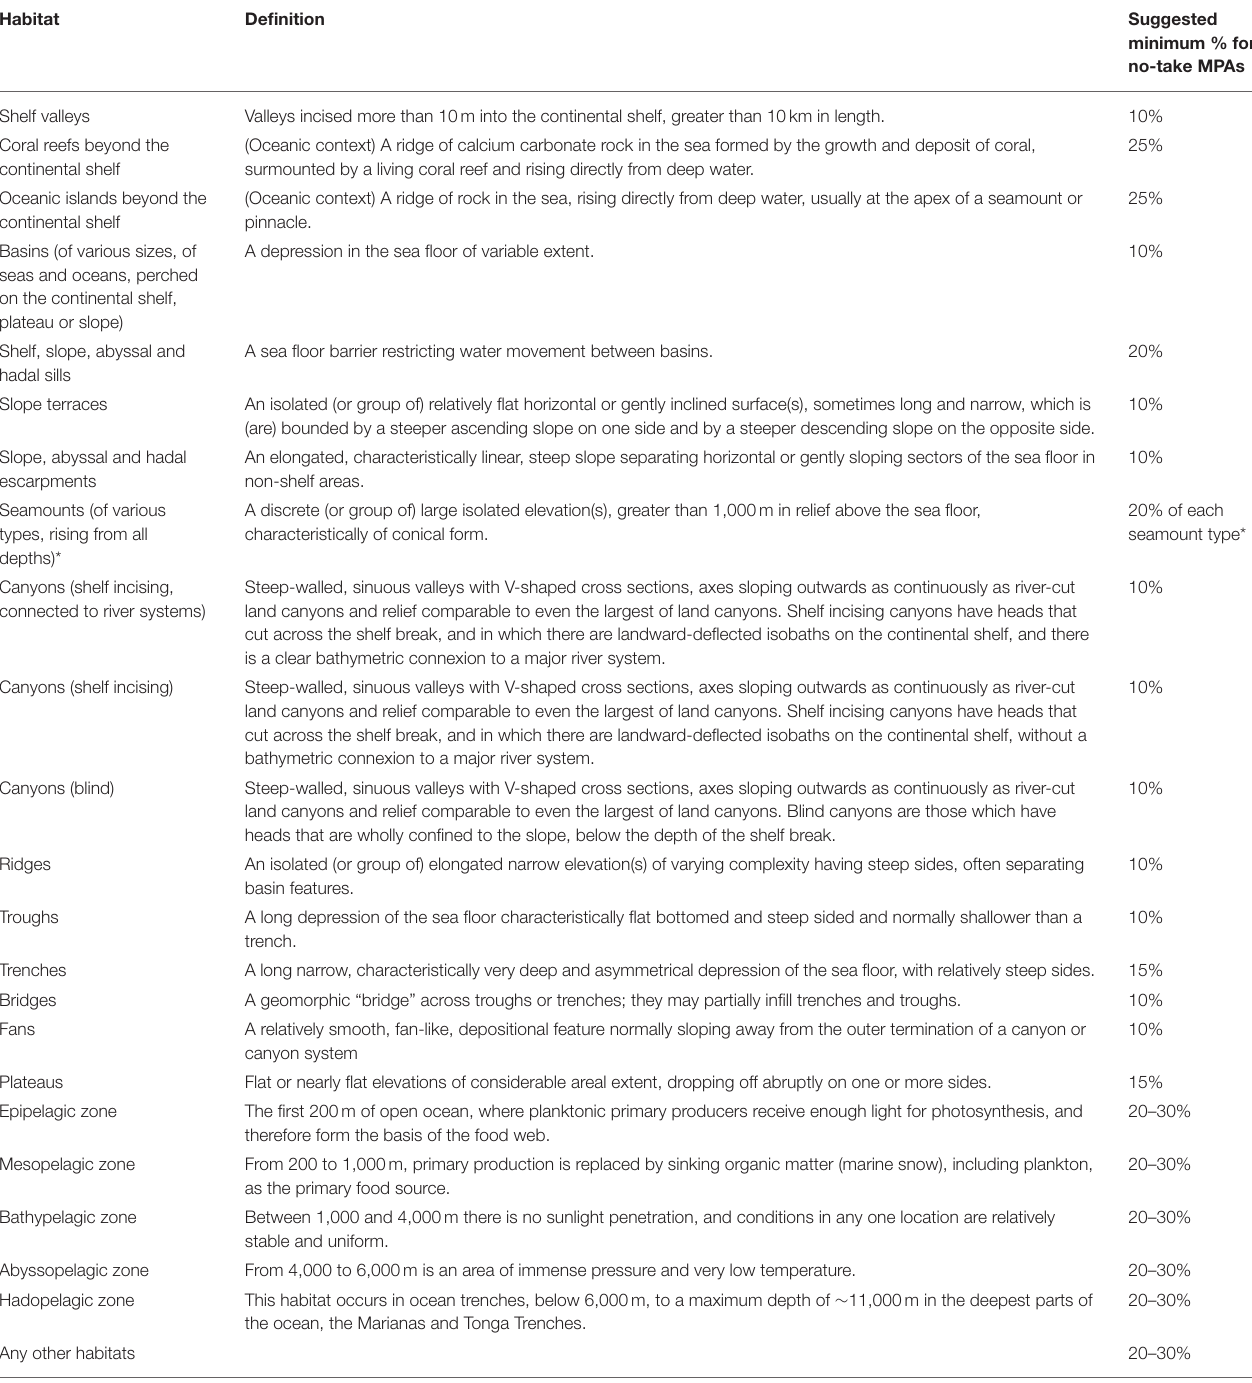
minimum % for no-take MPAs 25% 25% 20%